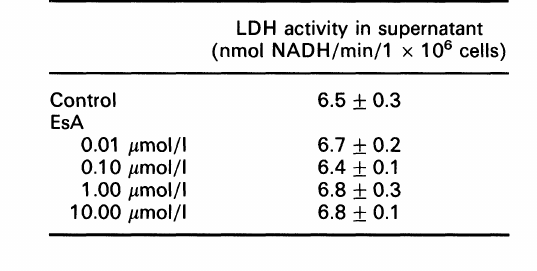
Table 2. LDH activities in supernatants from peritoneal macrophages incubated with or